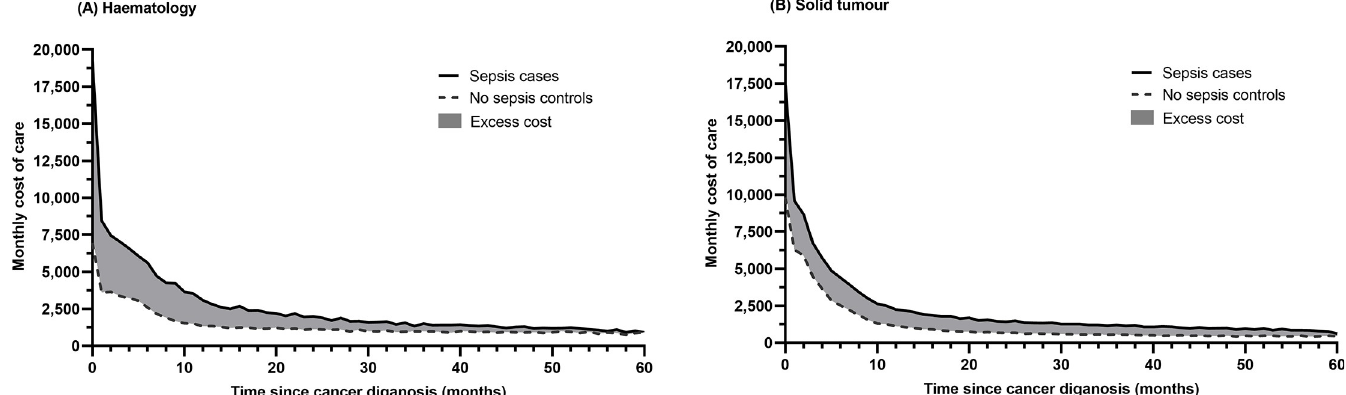
Fig 1. Mean monthly cost of care by malignancy type. (A) Haematolgy. (B) Solid tumour. The shaded area represents excess cost associated with sepsis, solid line represents mean monthly cost of care among sepsis (cases) and dotted line for no sepsis (controls).